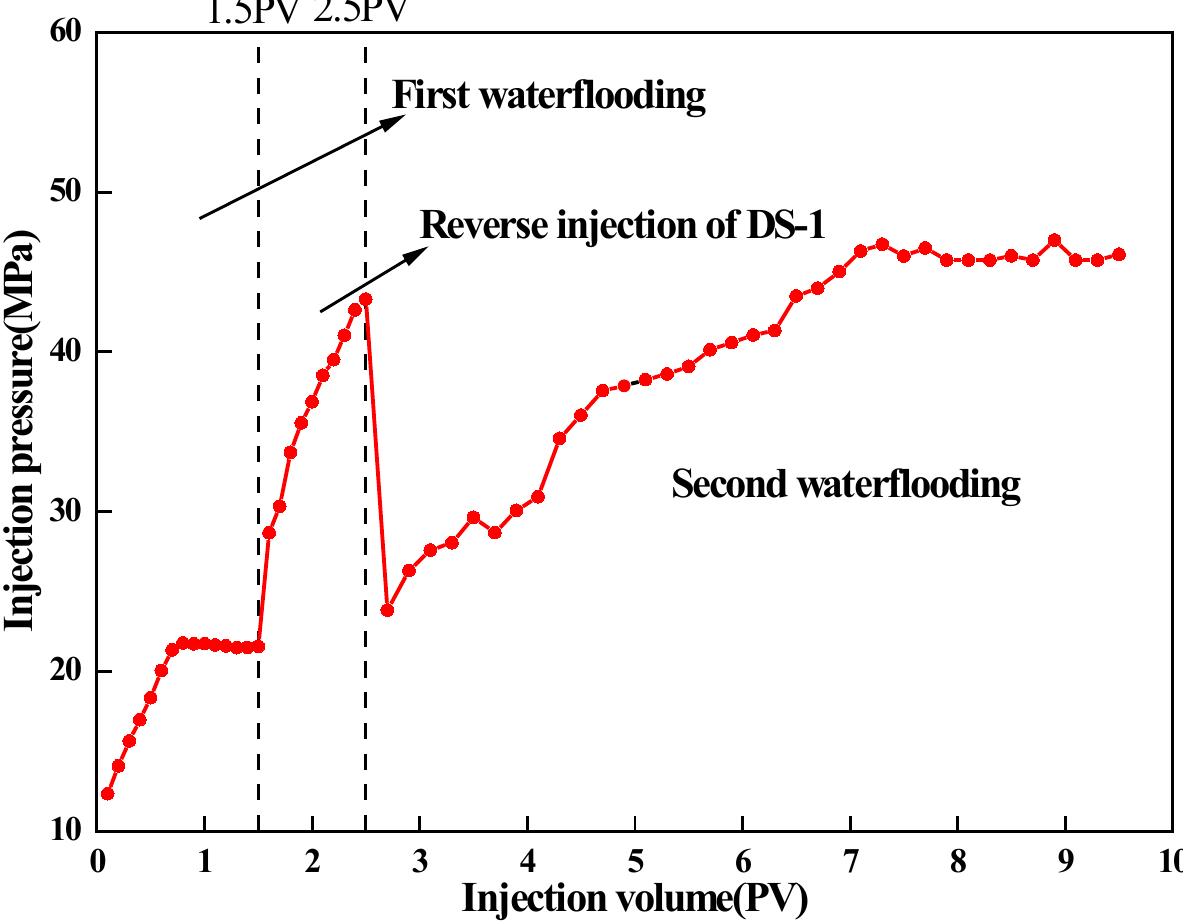
Figure 8. Test of plugging property of the swellable particles.